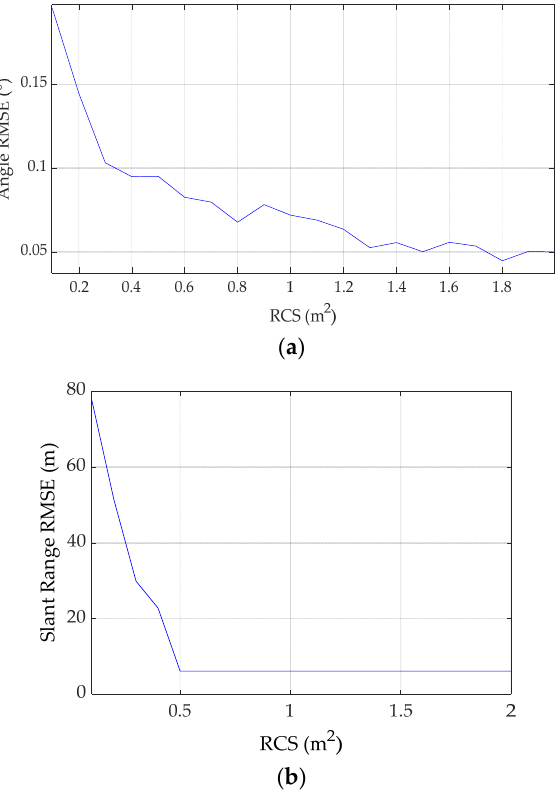
Figure 8. Target angle and slant range error estimation results: ( a ) RMSE of angle versus target RCS; ( b ) RMSE of slant range versus target RCS. Table 3. RMSE of range and angle of three